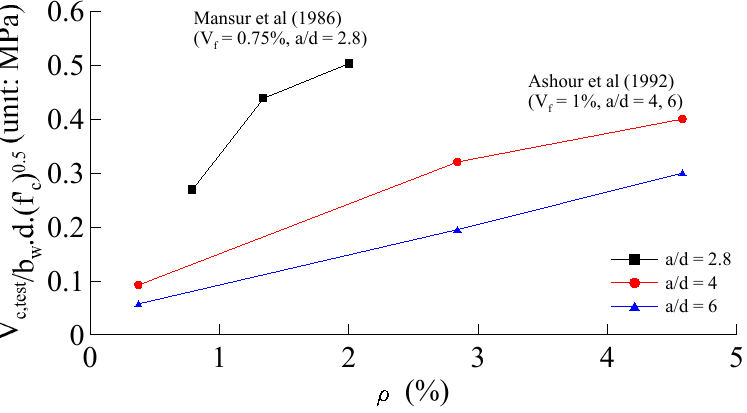
Figure 2. Relationships between normalized shear stress and longitudinal tensile reinforcement ratio [11,13].